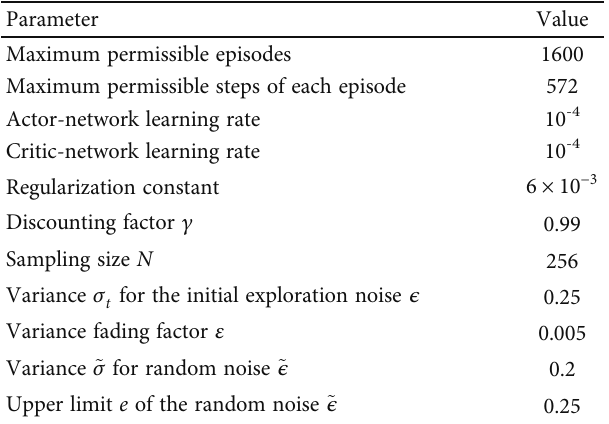
Table 2: TD3 algorithm